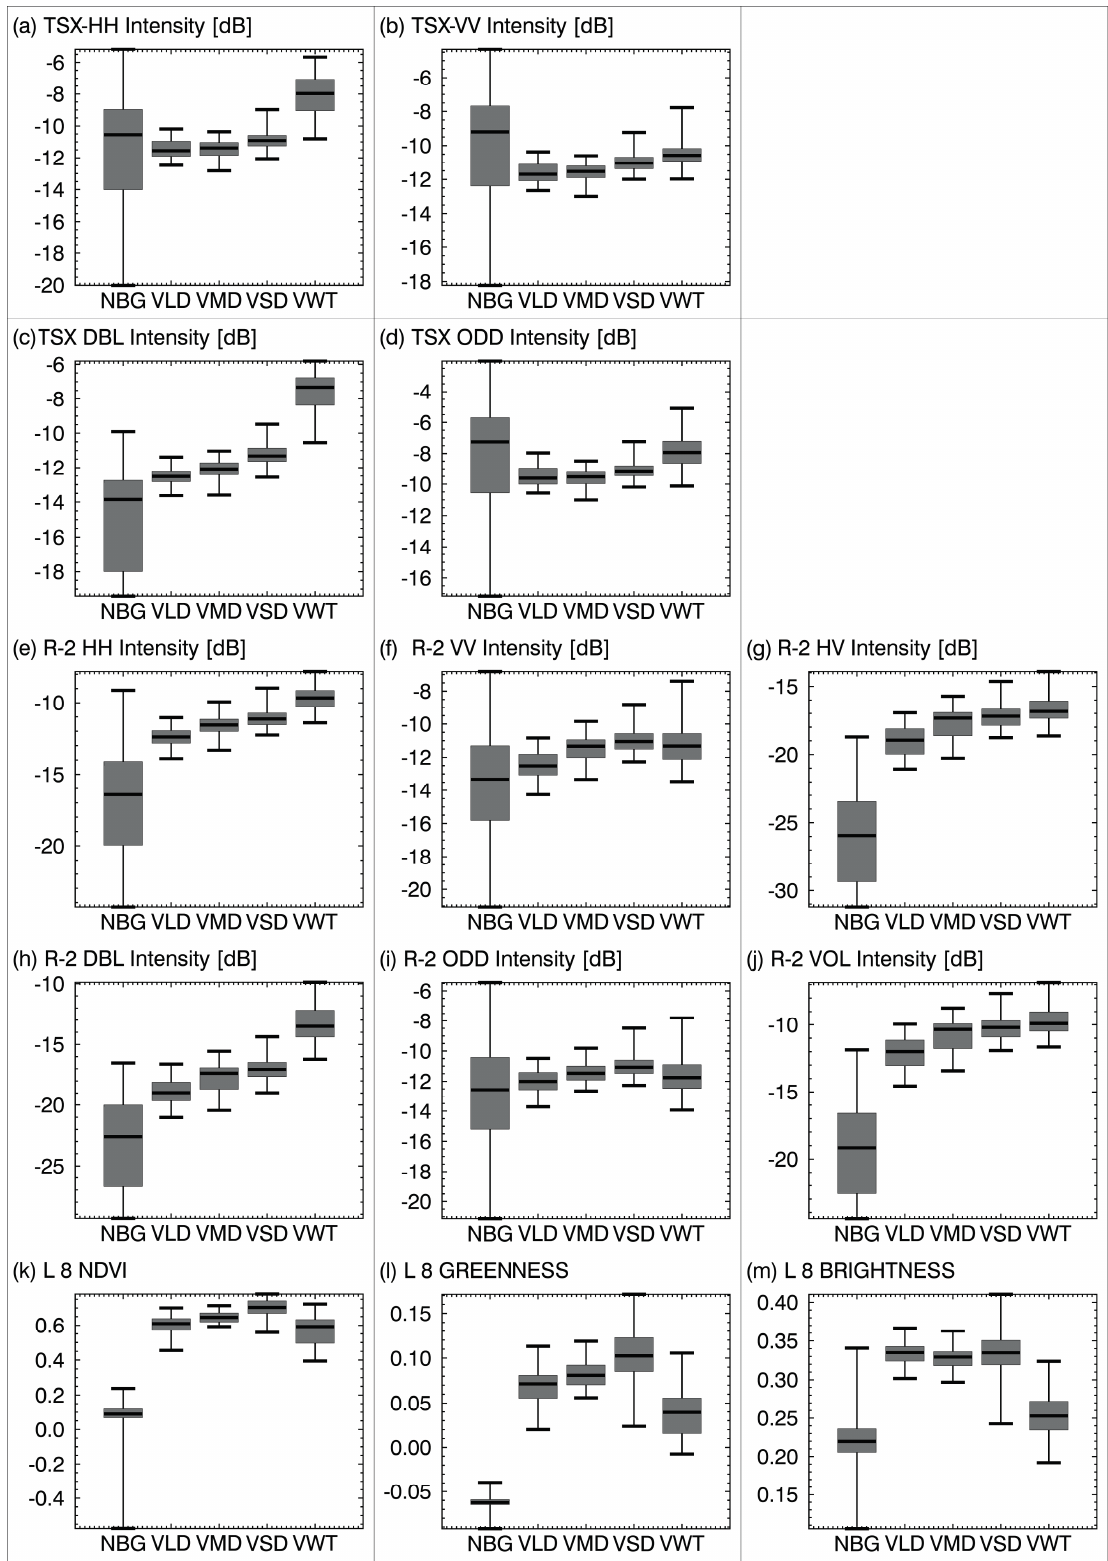
Figure 5. Boxplots of selected features of co-polarized TerraSAR-X data ( a – d ), quad-polarized Radarsat-2 data ( e – j ) (sigma nought intensities) and Landsat 8 (L 8) ( k – m ) with respect to ground truth land cover reference